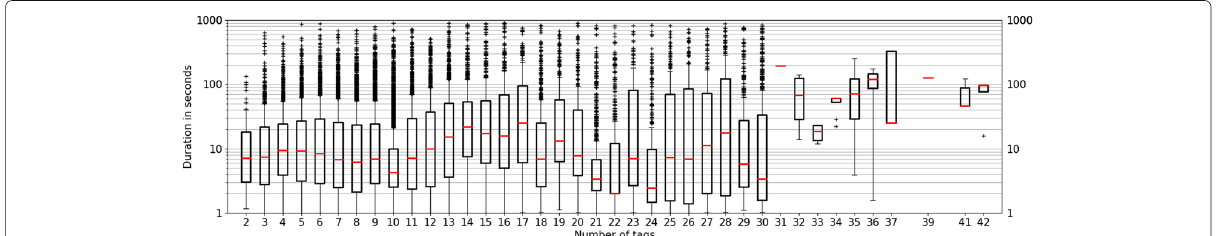
Fig. 7 Number of tags vs duration of files corresponding to ANPs with up to 43 tags. We expected that more tags will describe more audio content and therefore, correlate with longer durations. However, the correlation between number of tags and duration was weak or none. For instance, files with 16 and 27 tags will have the same average duration. A similar trend was observed for